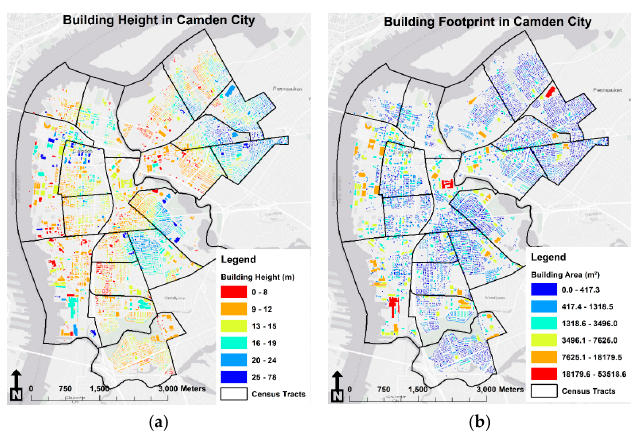
Figure 5. Environmental parameters mapped over Camden city: ( a ) building height (meters); ( b ) building area (meters 2 ).